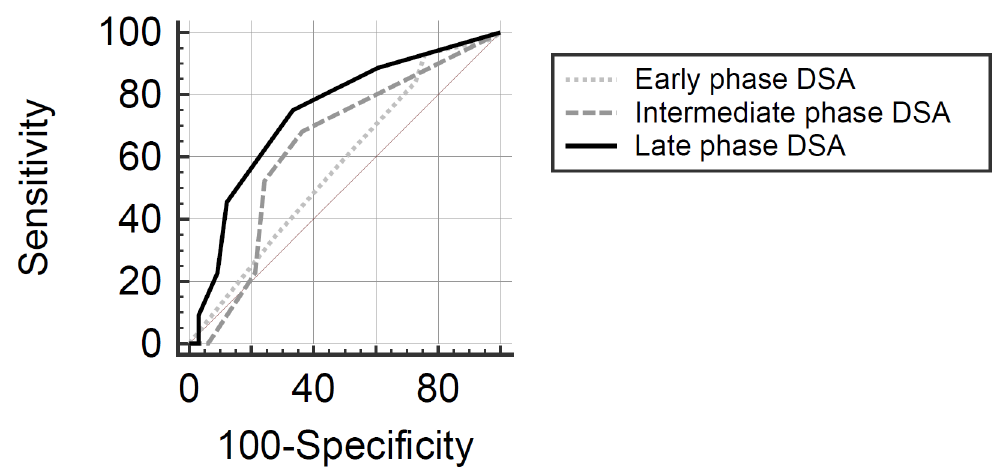
Fig 3. DSA-based rating of aneurysm opacification. Diagram shows receiver operating characteristic curves for classification of dichotomized neck coverage ratings based on early, intermediate and late phase DSA images. Intrasaccular stasis observed on late phase images had the highest area under the curve for discriminating favorable from unfavorable neck coverage.